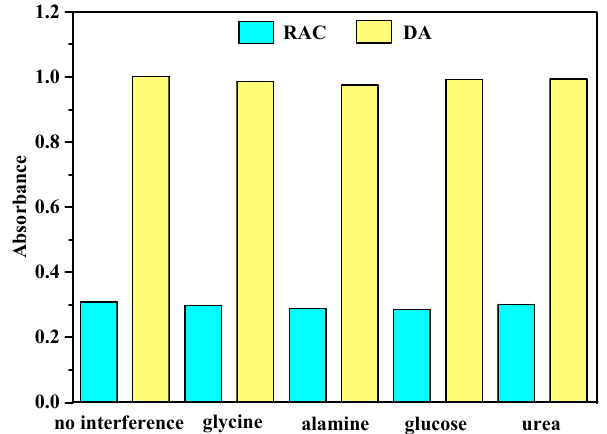
Figure 9. Comparison of the effect of interferences on the colorimetric detection of RAC and DA. Experiments for RAC: 100 µ L interference (5 mM), 80 µ L SiW 9 Cu 3 , 100 µ L RAC, 160 µ L H 2 O 2 , and reaction time of 25 min. Experiments for DA: 120 µ L interference (8 mM), 60 µ L H 2 O 2 , 120 µ L DA, 80 µ L SiW 9 Co 3 , and reaction time of 10 min.